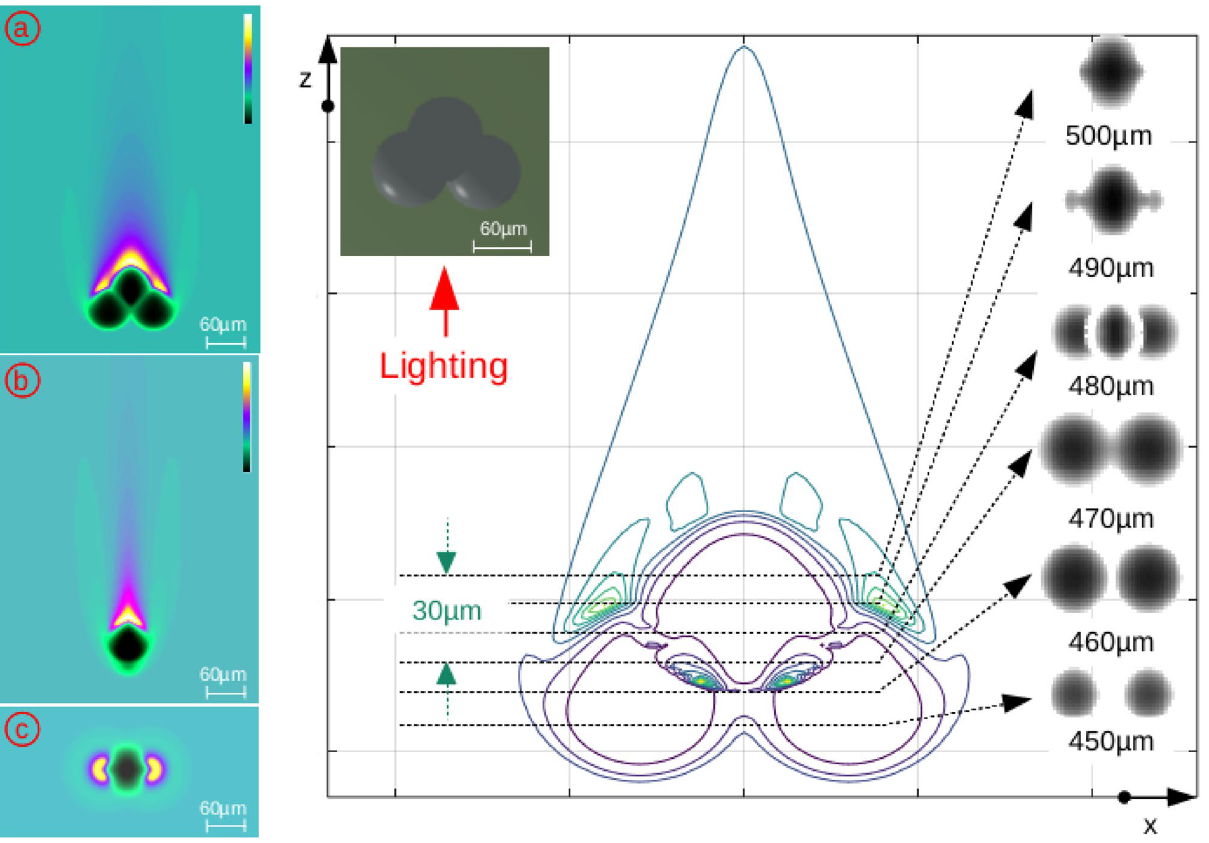
Figure 3. Three water bubbles: at the left, ( a ) “xz” plane, ( b ) “yz” plane and ( c ) “xy” plane, and at the right, the irradiance contour in an “xz” plane with several images in gray levels ( arbitrary Y scale